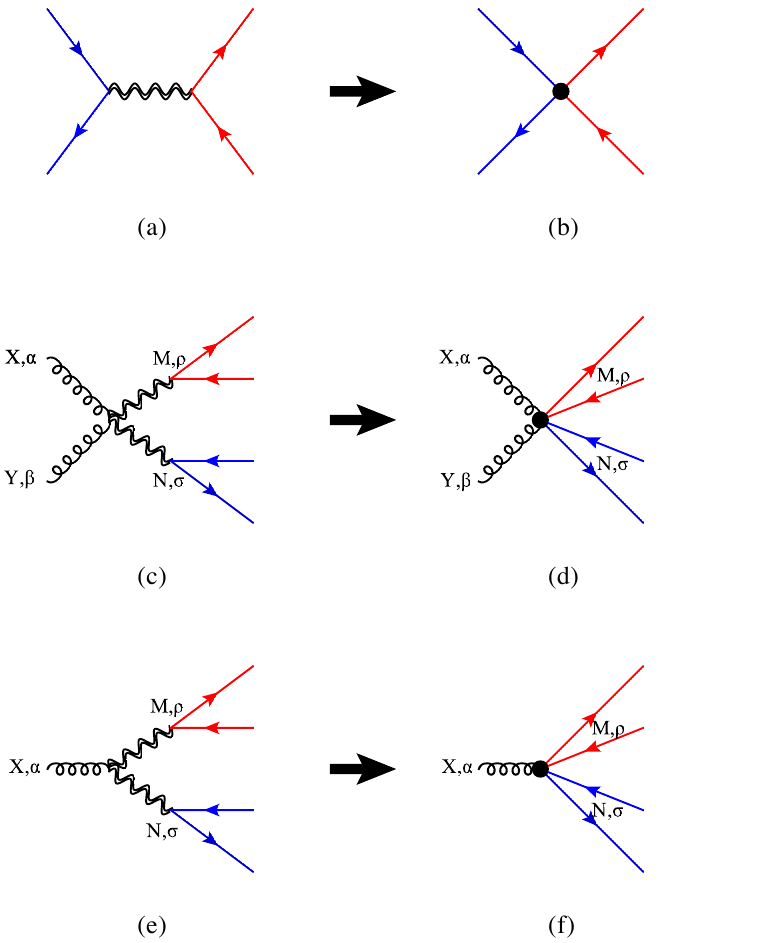
Figure 16 . Matching in the axigluon model. Red and blue fermion lines represent top-quark and bottom-quark currents. Double wavy line represents the axigluon. A blob represents the insertion of an e(cid:11)ective operator. (a), (c), (e) are diagrams in the full theory, which are replaced by (b),